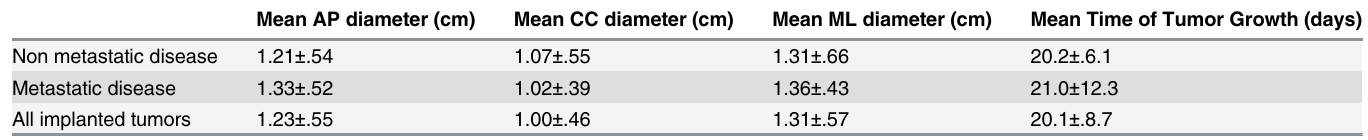
Table 1. Mean tumor growth